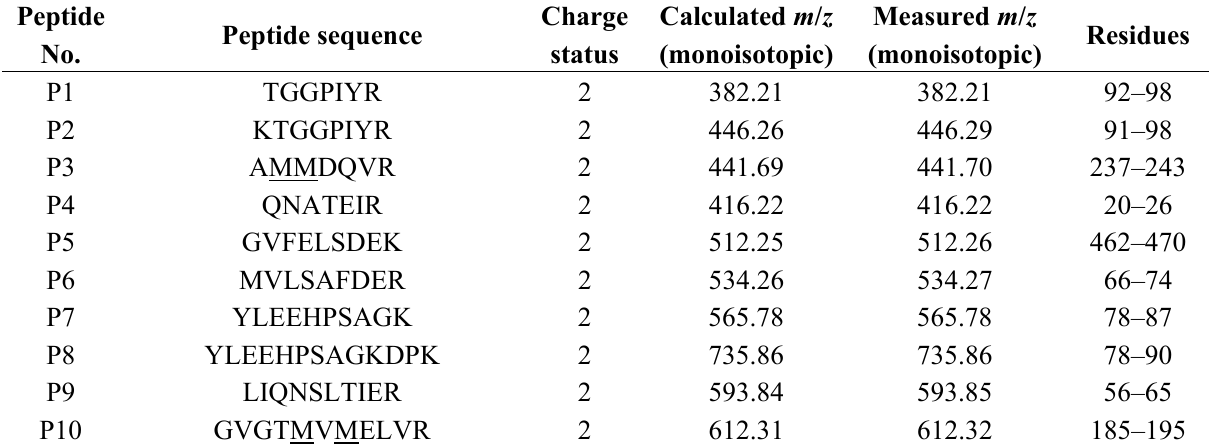
Table 1. Summary of tryptic peptides identified in nucleocapsid protein from influenza virus (A/Puerto Rico/8/1934 H1N1) by database